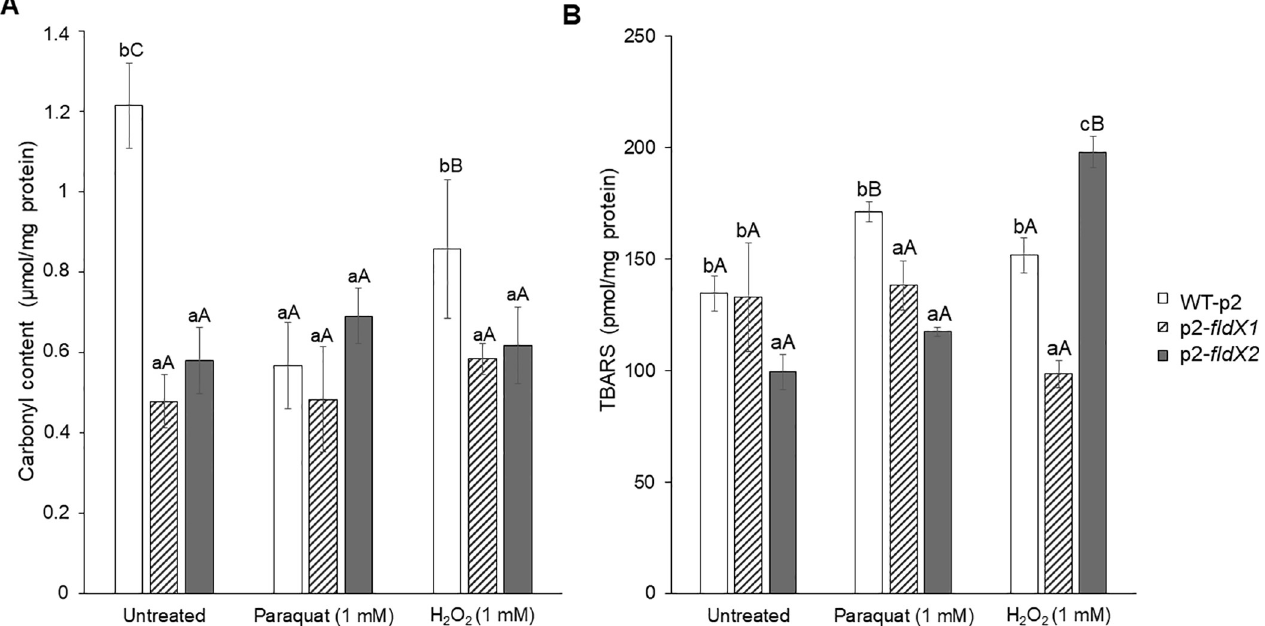
Fig 6. Protective effects of the flavodoxins on macromolecules damage of P . xenovorans after exposure to oxidizing agents paraquat and H 2 O 2 . (A) For protein carbonylation, nucleic acid-free protein extracts were derivatized with DNPH. After addition of 6 M NaOH, the product was measured spectrophotometrically. (B) Lipid peroxidation was measured by the thiobarbituric acid reactive substances (TBARS) assay. Samples were incubated with TBA for 1 h at 100˚C and measured spectrophotometrically. Significant differences were determined with a Tukey Test (p < 0.05) as indicated. Lower case letter under the error bars indicate significant differences between strains in each treatment. Capital letter under the error bars indicate significant differences between treatments for each strain. Each value is an average ± SD of at least three independent experiments.